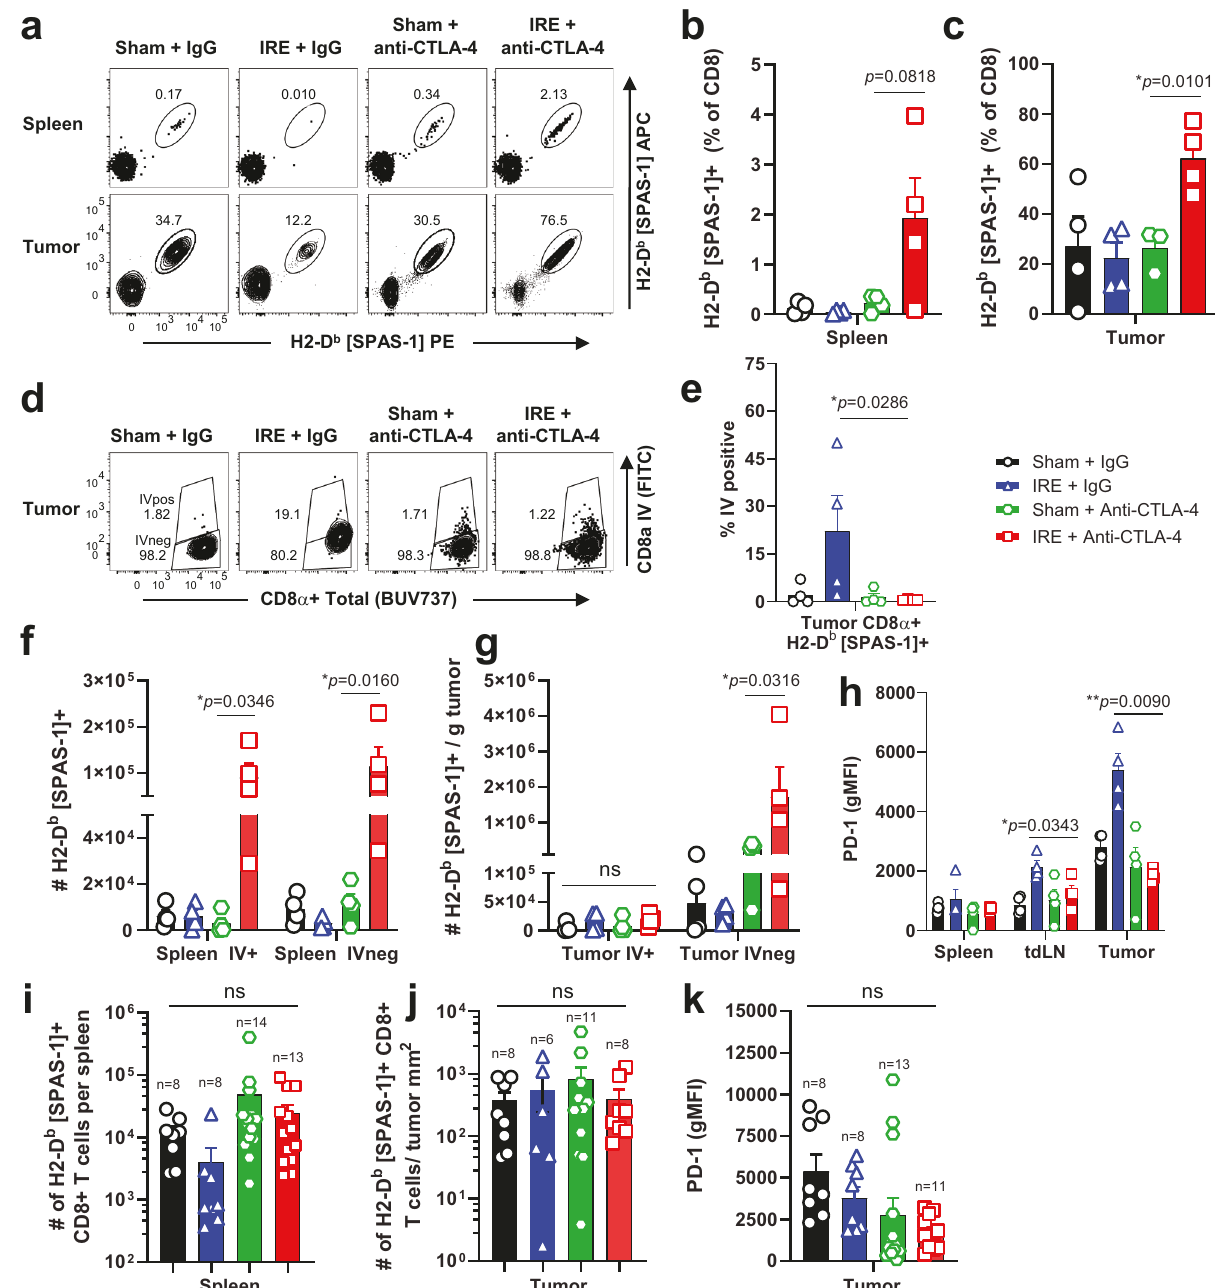
Fig. 6 Combination therapy is associated with increased numbers of tumor-speci fi c SPAS-1 + T cells in spleen and tumors. Mice bearing ~4 – 5 mm diameter TRAMP-C2 tumors were treated with Sham, IRE, and/or anti-CTLA-4 as in Fig. 4. On day 14 ( a – h ) or day 21 ( i – k ) following therapy, single-cell suspensions from the indicated tissues were analyzed by fl ow cytometry. Data in ( b – h ) represent individual mice ( n = 4/group) pooled from two independent experiments, and i – k represent individual mice ( n = 6 – 14/group) pooled from four independent experiments, with exact n shown for each group. a Representative tetramer staining of SPAS-1 from spleen and tumor samples in each treatment group, gated on Live, Thy1.2 + CD8 + T cells. b , c Frequency of SPAS-1 + T cells in spleen and tumor, respectively. Intravascular (IV) anti-CD8 α was injected 3 min prior to sacri fi ce. d , e Representative fl ow cytometry plots and quanti fi cation, respectively, gated on Thy1.2 + CD8 + SPAS-1 + T cells, showing IV CD8 α stain used to segregate the IV-negative and -positive fractions from each treatment group. f – g Total number of SPAS-1 + CD8 + T cells in the indicated IV fraction of spleen and tumor, respectively. h , k PD-1 expression at days 14 and 21, respectively. i – j Total number of SPAS-1 + T cells in the IV-negative fractions of spleen and tumor, respectively at day 21 following the start of therapy. Bars represent mean ± S.E.M. b , c , e – k , Unpaired two-tailed T test with Holm-Sidak ’ s correction was performed; ns, not signi fi cant, * p < 0.05, ** p < 0.01. Source data are provided as a Source Data